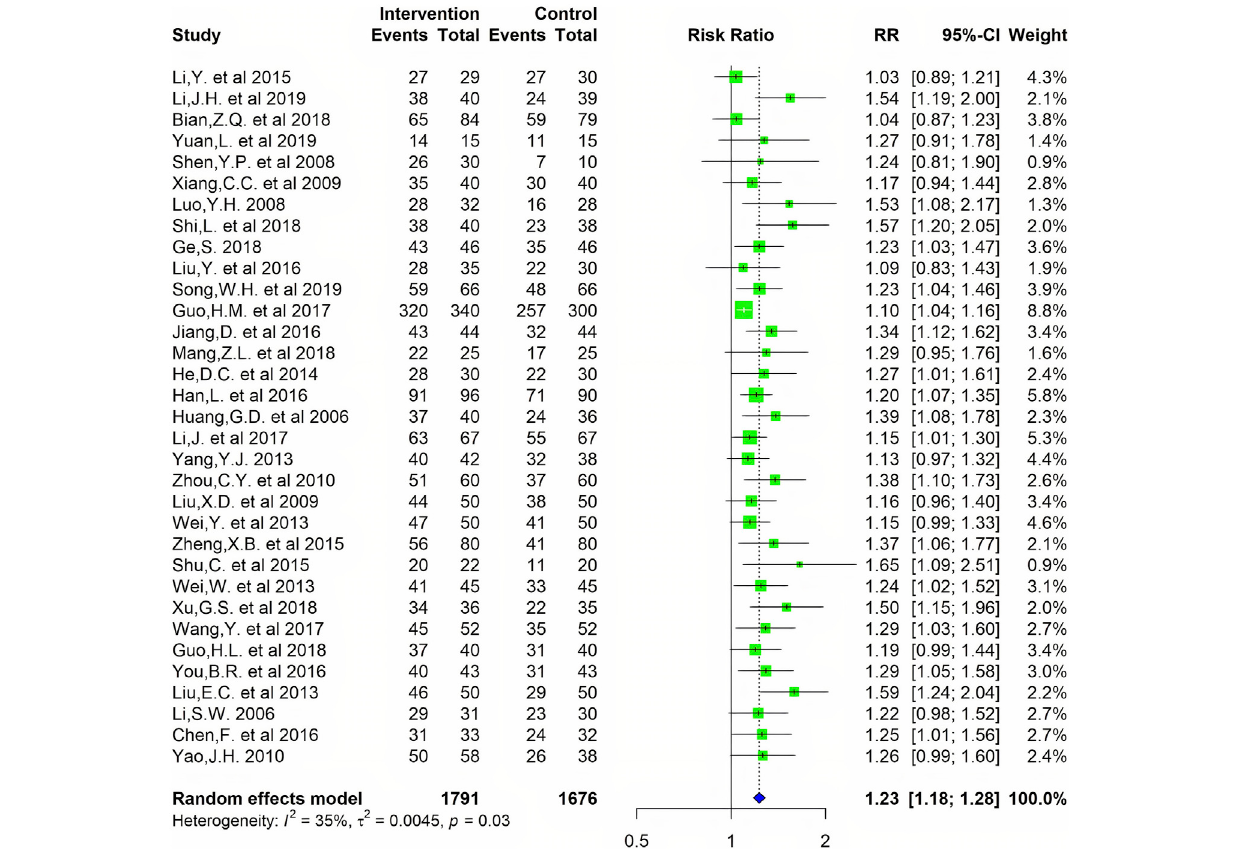
FIGURE 5 | Forest plot and meta-analysis of ACR